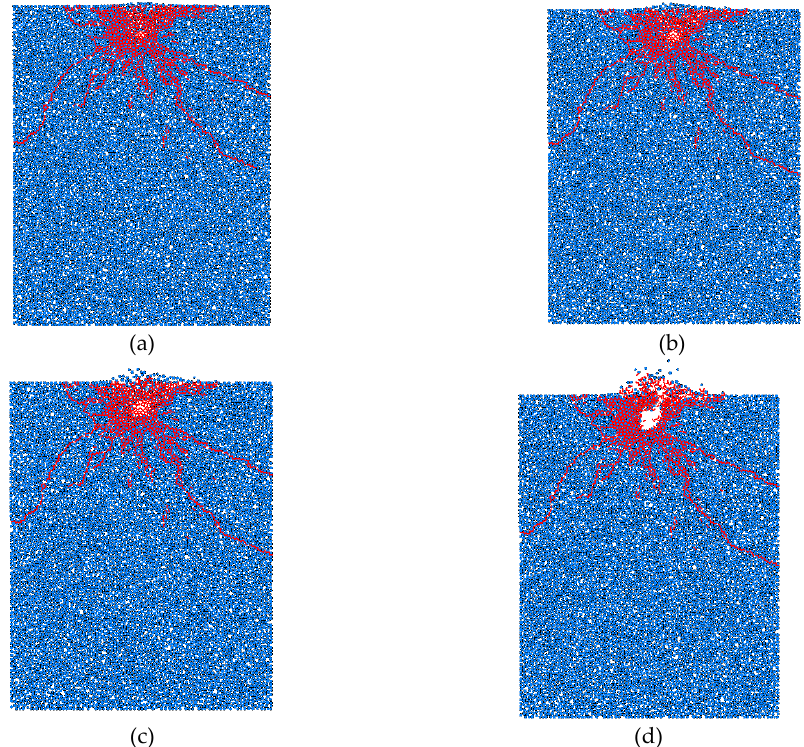
Figure 11. Surface cracking and crack propagation of EPB in granite at t = 200 μs, using different capacitances with U = 10 kV: (a) C = 0.5 μ F, (b) C = 0.8 μ F, (c) C = 5 μ F, and (d) C = 8 μ F.